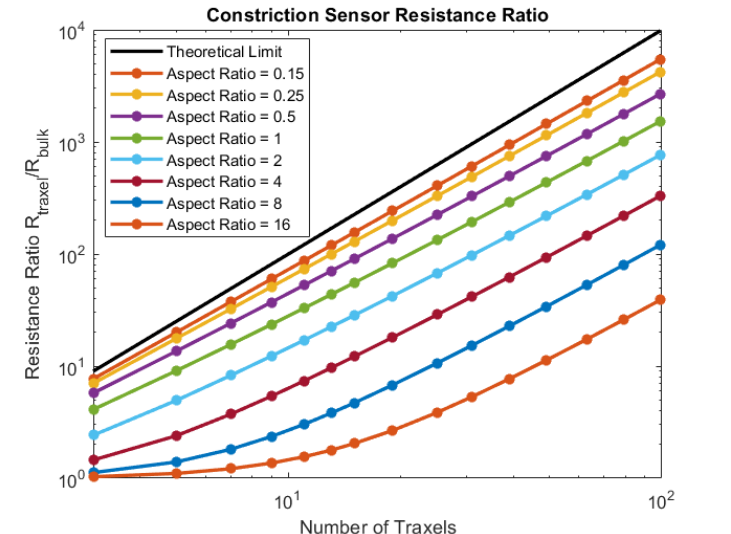
Figure 32. The modeled traxel resistance to bulk resistance ratio as a function of the number of traxels (e.g., the ratio between the maximum and minimum total resistance in Figure 31), for several aspect ratios. Hence, increasing the number of traxels and decreasing the aspect ratio will increase the traxel/bulk resistance ratio of the sensor. In theory, the ratio is limited by the number of traxels, as given in Equation